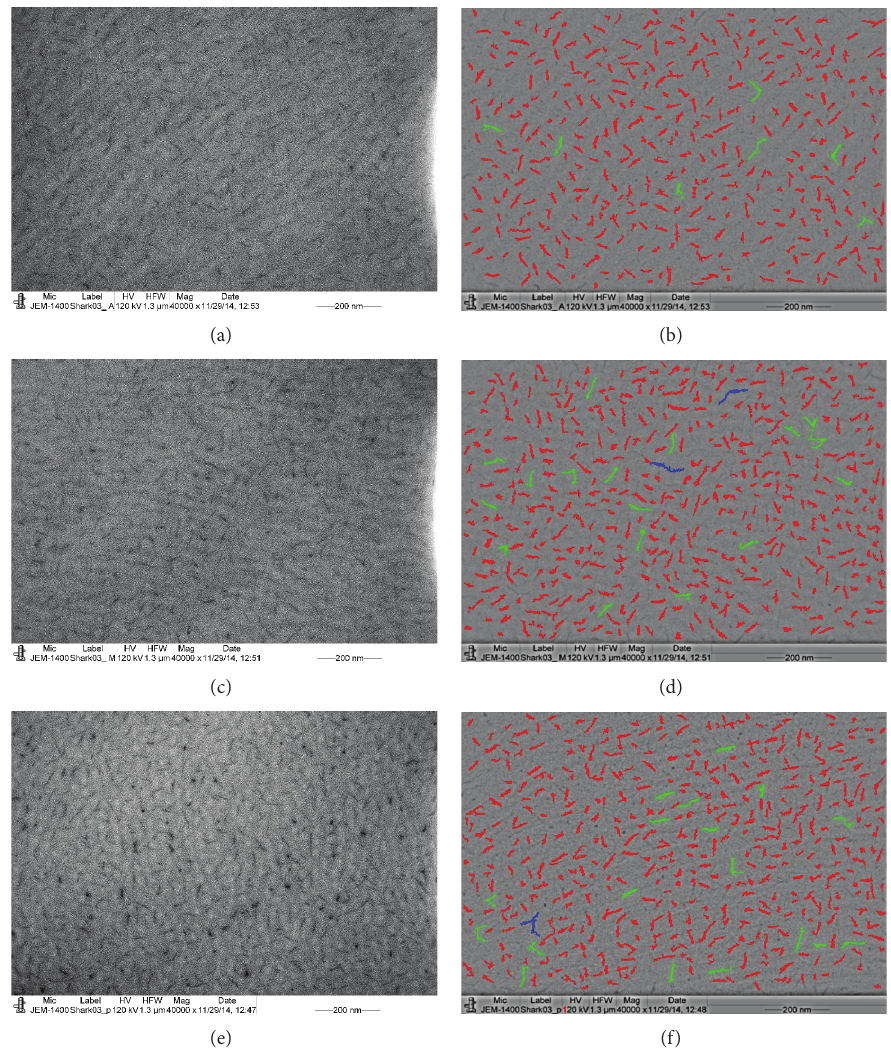
Figure 7: Electron micrograph and colour coded digital images of the PGs of shark. The electron micrograph was taken from section of corneal stroma that was not stained with uranyl acetate and lead citrate; (a) electron micrograph of PGs of the anterior stroma; (b) colour coded digital image of (a); (c) electron micrograph of PGs of the middle stroma; (d) colour coded digital image of (c); (e) electron micrograph of PGs of the posterior stroma; (f) colour coded digital image of (e). Red: 50–257, green: 257–464, blue: 464–671, yellow: 671–878, terracotta: 878–1045, pink: 1085–1292, and brown: 1292–1500.